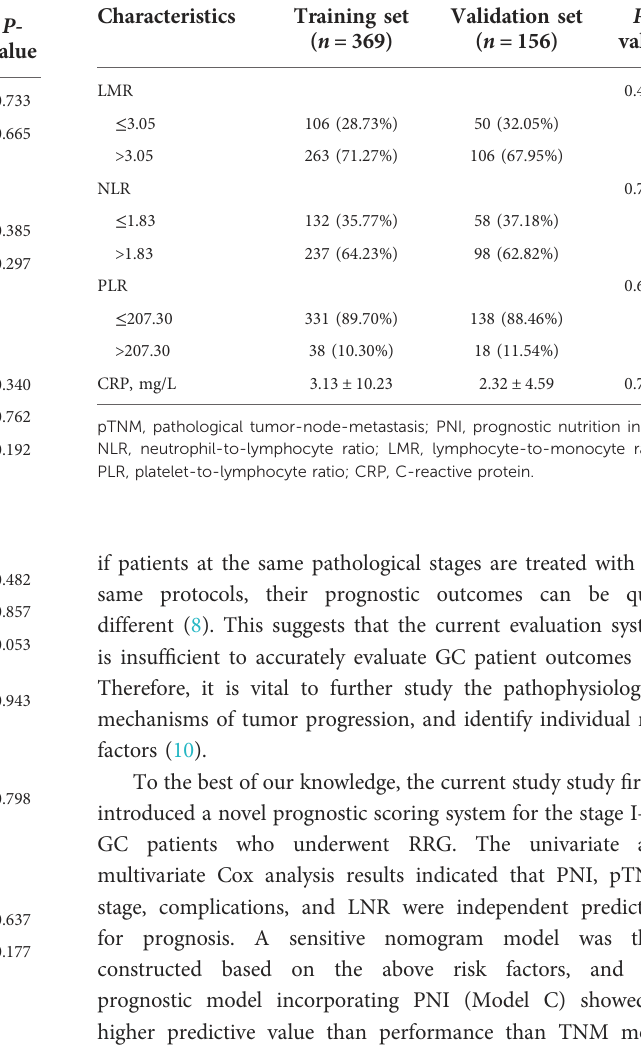
TABLE 1 Clinical characteristics of patients in the training set and validation